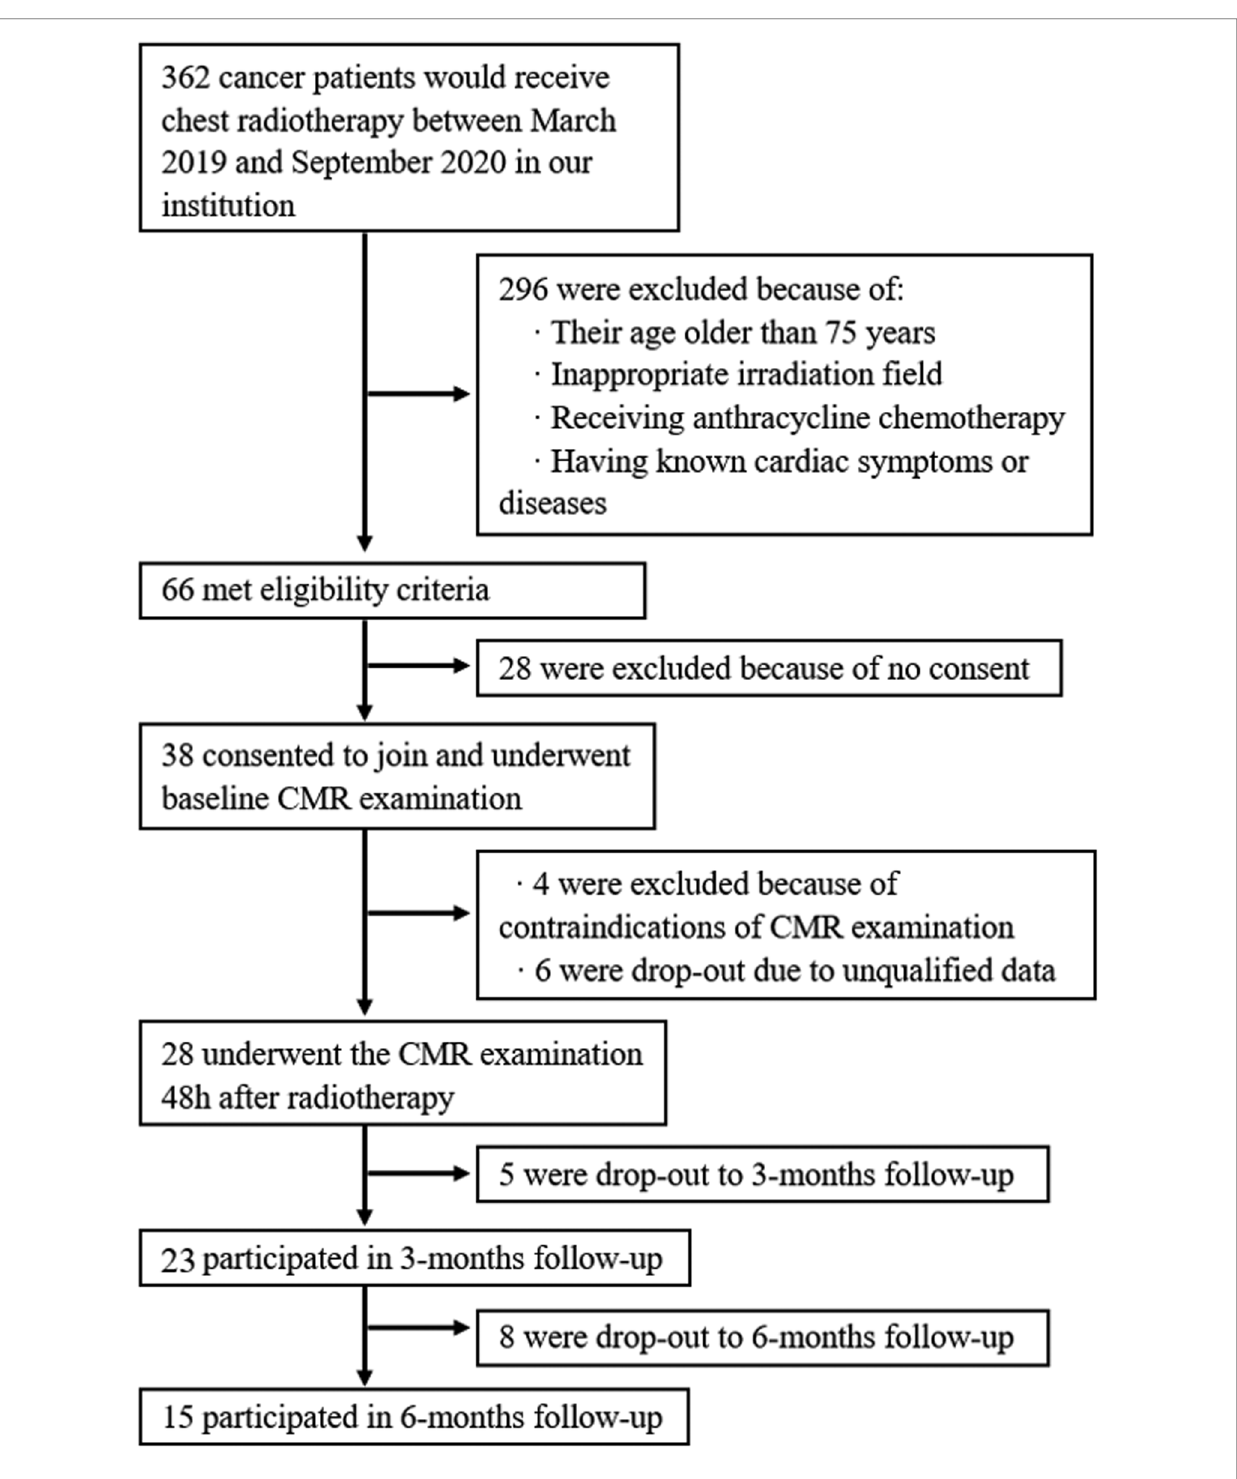
FIGURE 2 STROBE fl ow